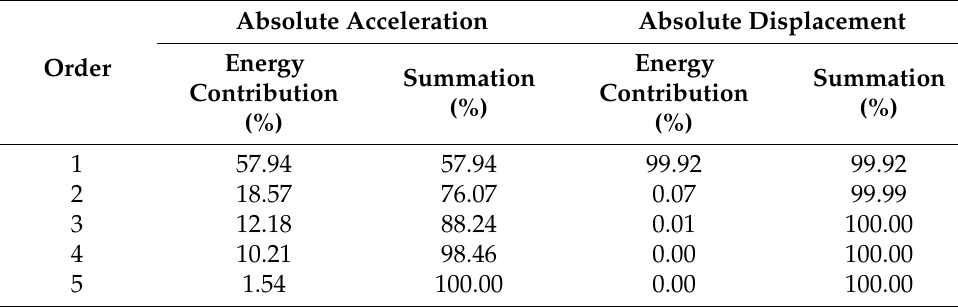
Table 3. Energy contribution of different modes of five-story